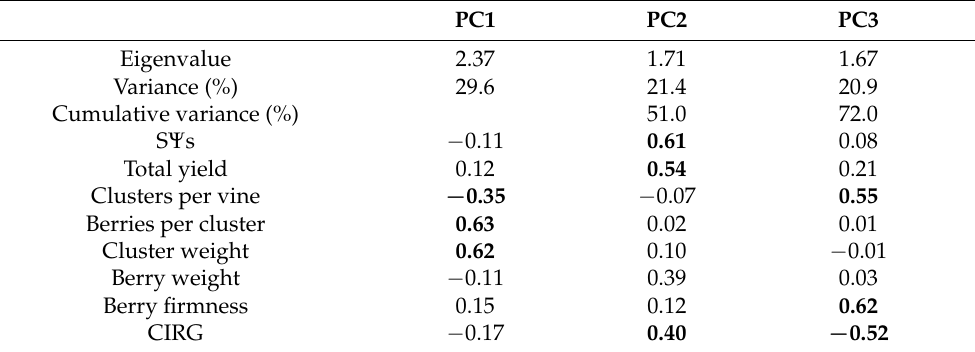
Table 2. Principal component analysis (PCA): eigenvalues, percentage of variation accounted by the first three principal components (PC), and eigenvectors of the productive and quality variables on ‘Crimson Seedless’ vines under different water stress intensities during post-veraison. PC1 PC2 PC3 Eigenvalue Cumulative variance (%) 51.0 S Ψ s − 0.11 Clusters per vine